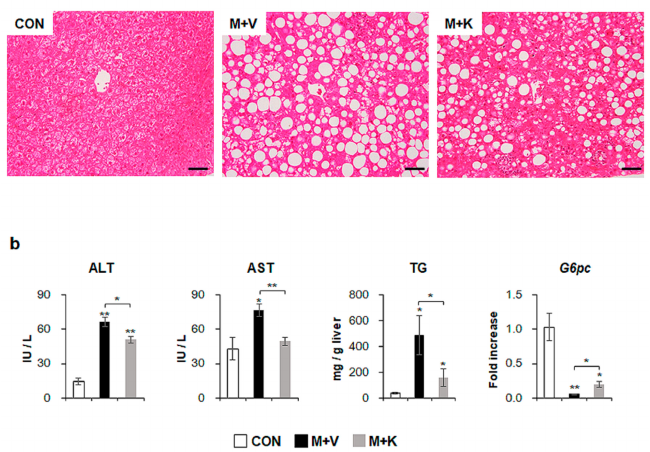
Figure 2. KTimprovesliverhistomorphologyandfunctionofMCD-treated db / db mice( a )Hematoxylin-eosin (H&E) staining shows the representative liver morphology of each group (Scale bars: 50 µ m). ( b ) Levels of alanine transaminase / aspartate transaminase (ALT / AST) in serum, hepatic triglyceride, and G6pc mRNA in liver of each group were graphed as mean ± SEM ( n ≥ 3 / group, * p < 0.05, ** p < 0.005 vs. control group). RNA expression of G6pc was expressed as fold